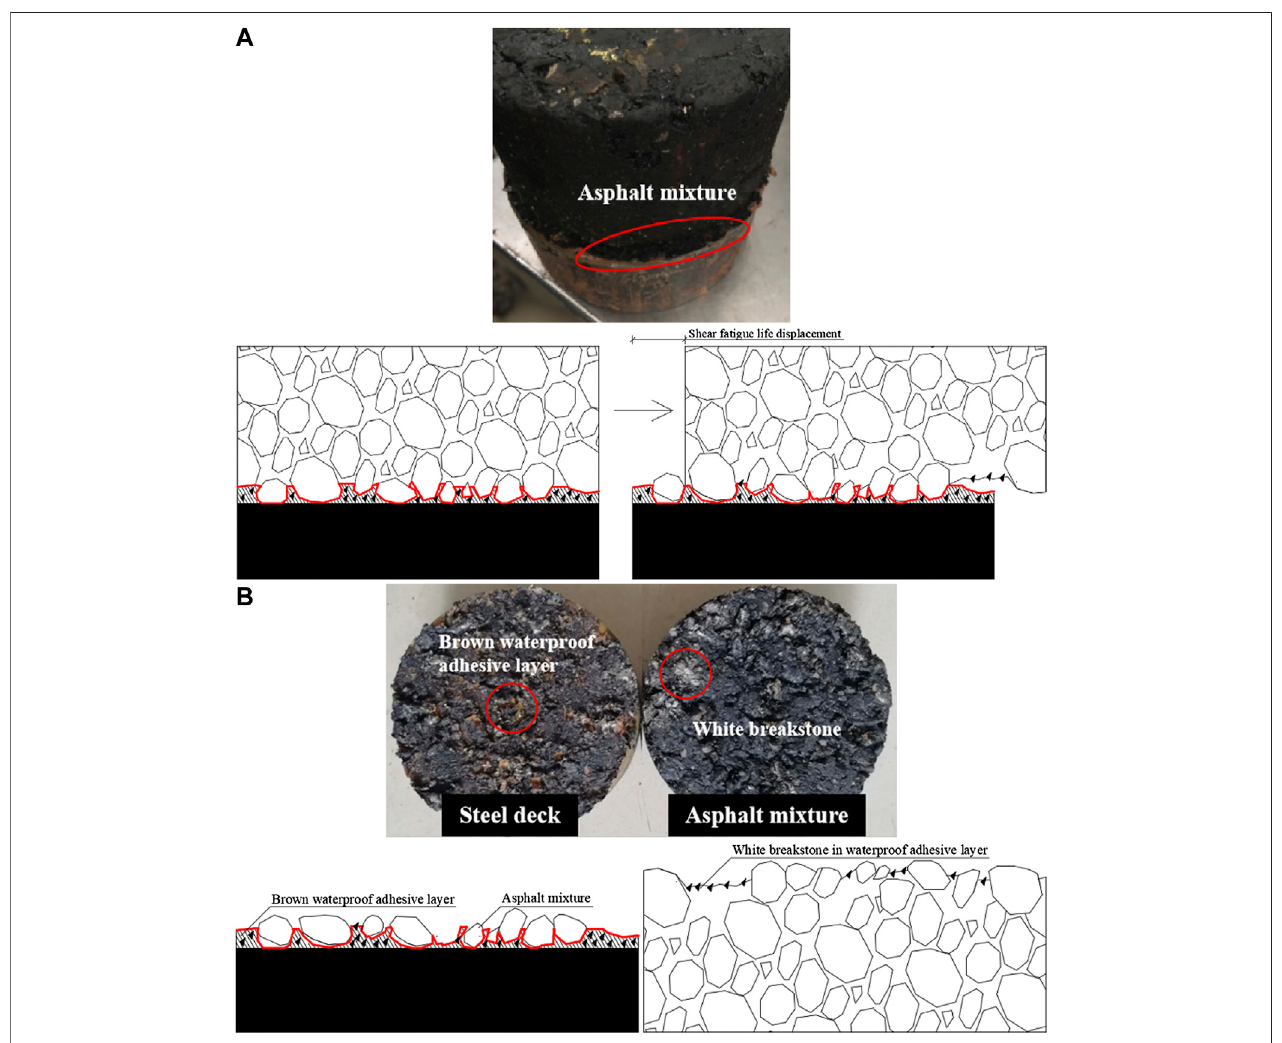
FIGURE 6 | Two kinds of shear fatigue failure states of